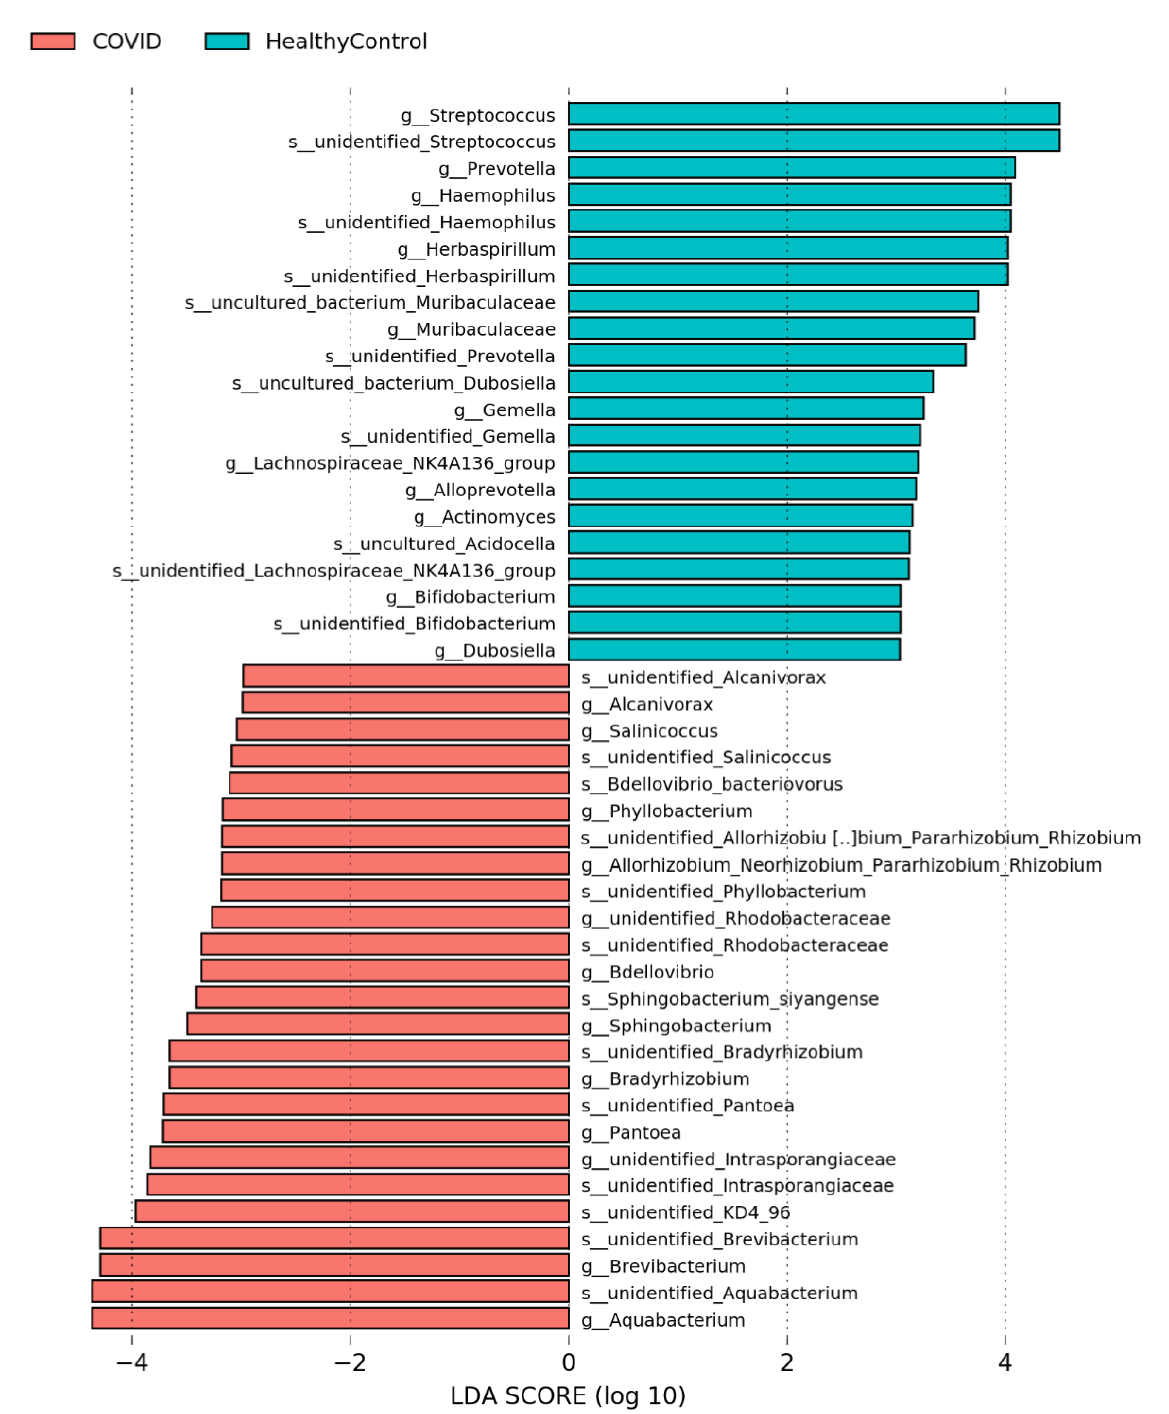
Figure 3. COVID-19-positive subjects exhibit significant dysbiosis of the plasma microbiome at the genus/species level. Linear discriminant analysis (LDA) of CPM normalized counts of Metaphlan displaying differential abundances of several prominent genera in the COVID-19 plasma samples including Bifidobacterium , Pantoea , Streptococcus , and Brevibacterium spp. 2.5. SARS-CoV-2 Infections Promote Gut Barrier Defects and Endotoxemia in COVID-19 Patients